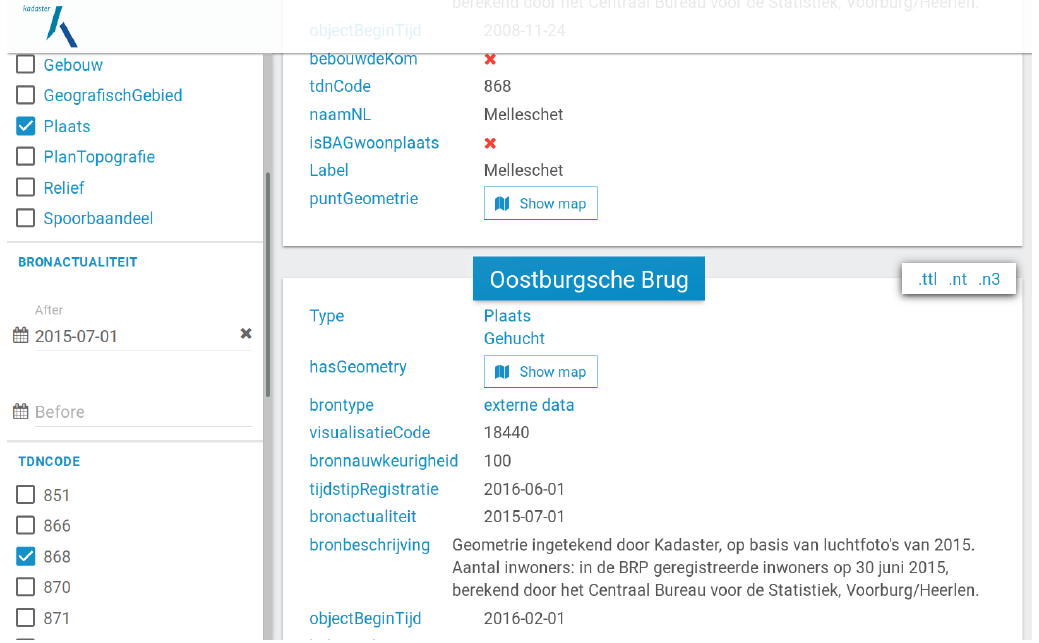
Figure 2. A view of the FacetCheck faceted browser. Selections that correspond to conjunctive filter expressions are made on the left-hand side. In this example this results in a list of places whose record has been updated on or after the first of July 2015, and whose TDN code is